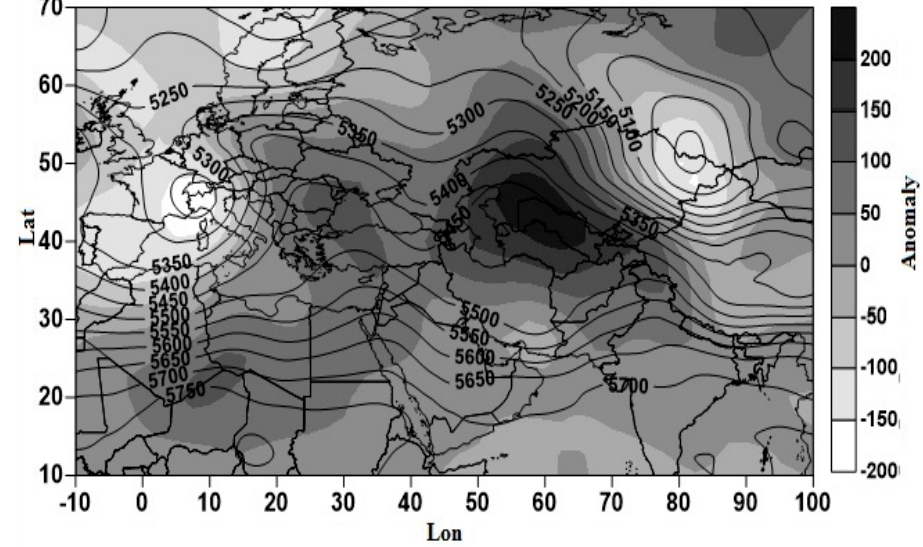
Figure 11. Anomalies and atmosphere thickness (in meters) for the representative day of the fifth pattern. fifth